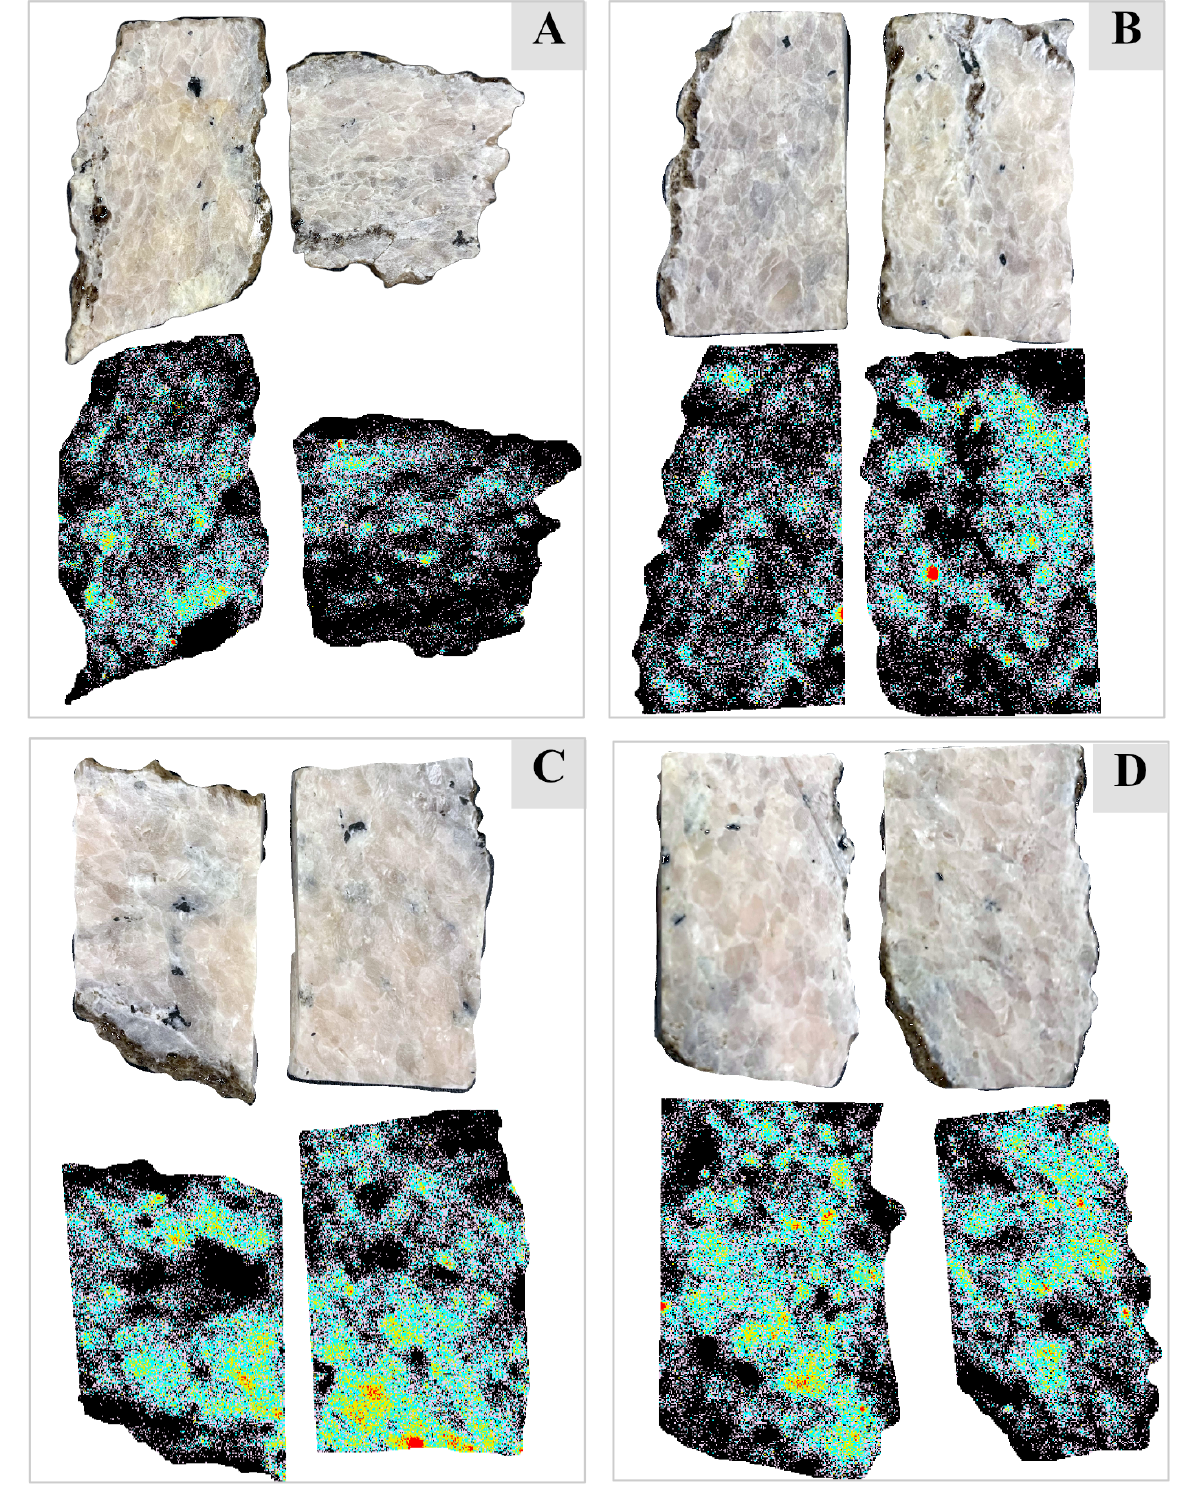
Figure 11. VNIR continuum-removed true-color hyperspectral images of the carbonatite samples along with the images classified using the decision tree algorithm. Based on the depth of the Nd absorption feature at ~810 nm, the relative abundance of the Nd in the samples is broken down into five classes (class 1: red pixels showing the highest Nd concentration; class 2: yellow pixels; class 3: cyan pixels; class 4: lemonade pixels; class 5: black showing little to no Nd). ( A ) sample SP1; ( B ) sample SP7; ( C ) sample SP8; ( D ) sample